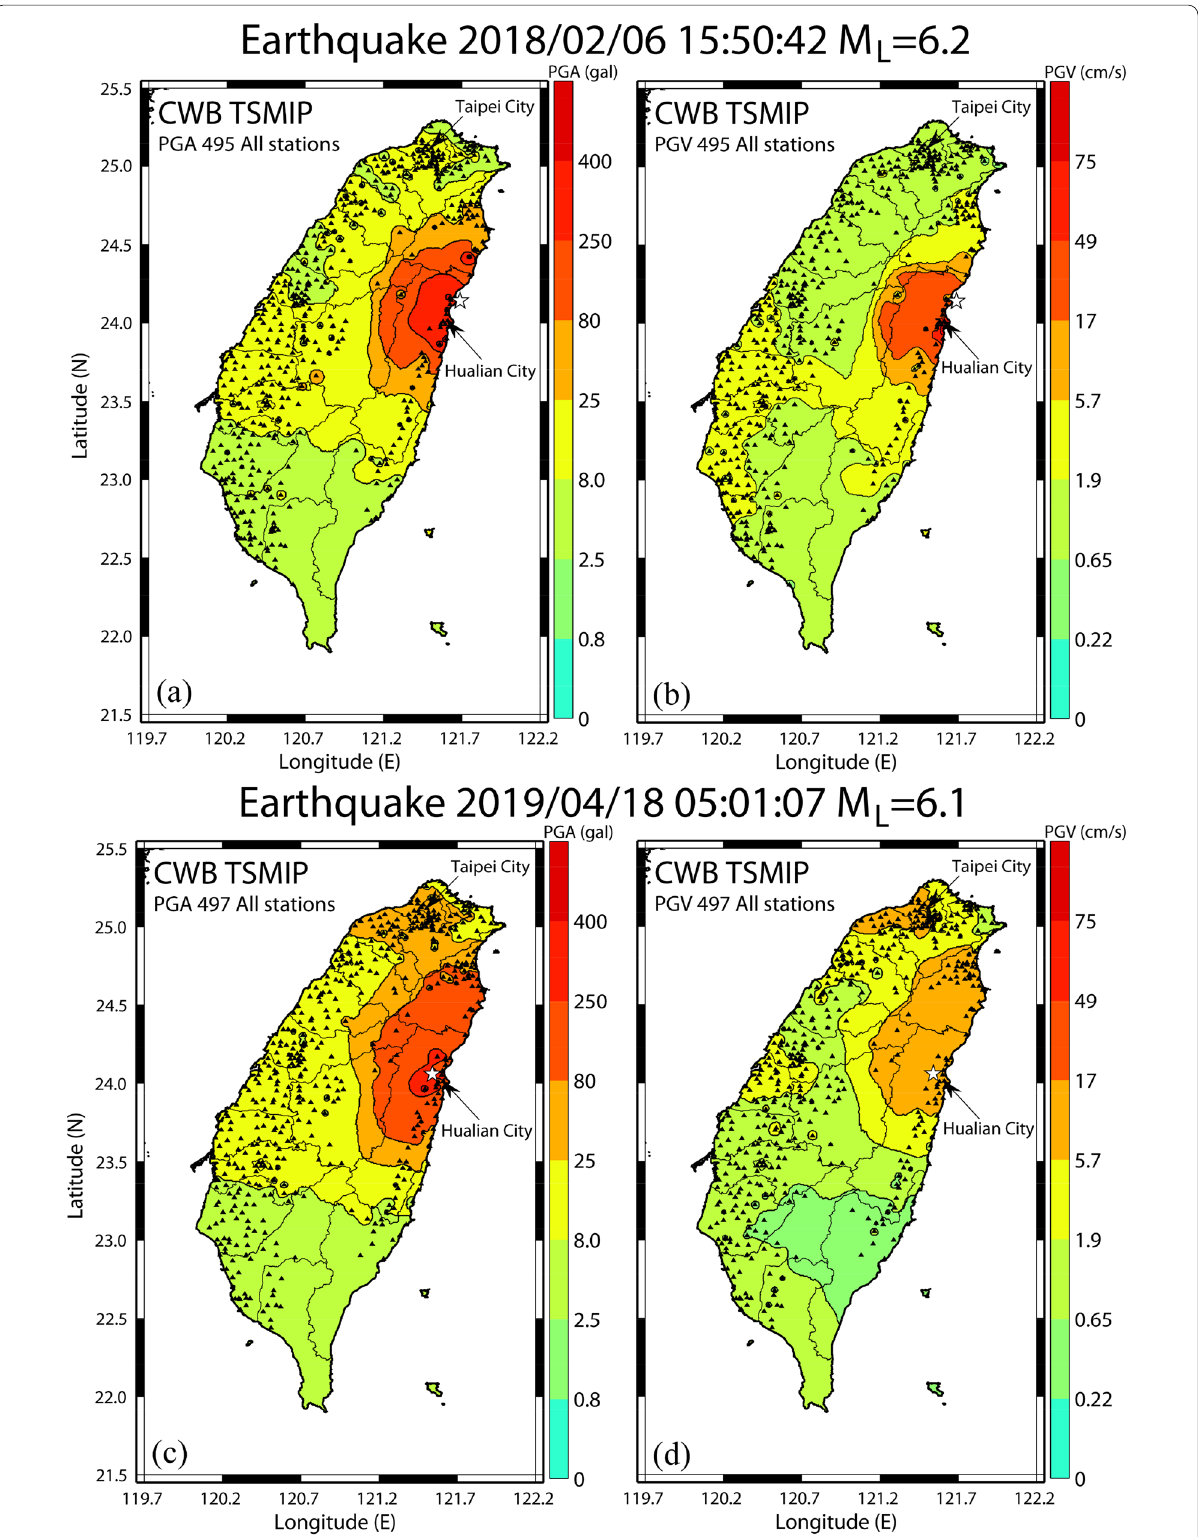
Fig. 9 The plotted a PGA and b PGV shakemaps for the 2018 Hualien earthquake ( M L earthquake ( M L =